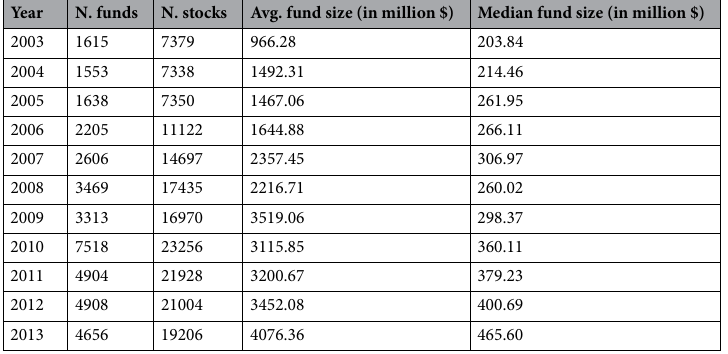
Table 1. Summary statistics. For each year, the table reports: the number of funds, the number of stocks, the average and the median size of the funds,